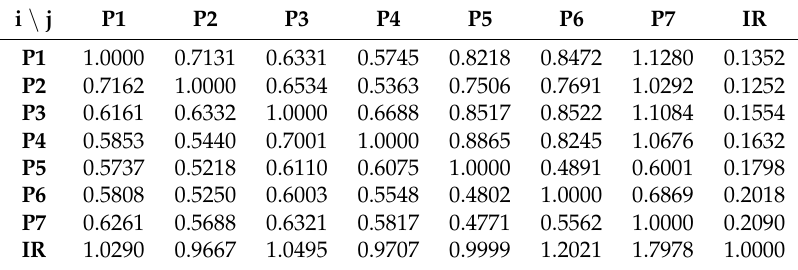
Table 1. Mutual spectral interference Θ coefficients of the spectral sensor efficiencies.